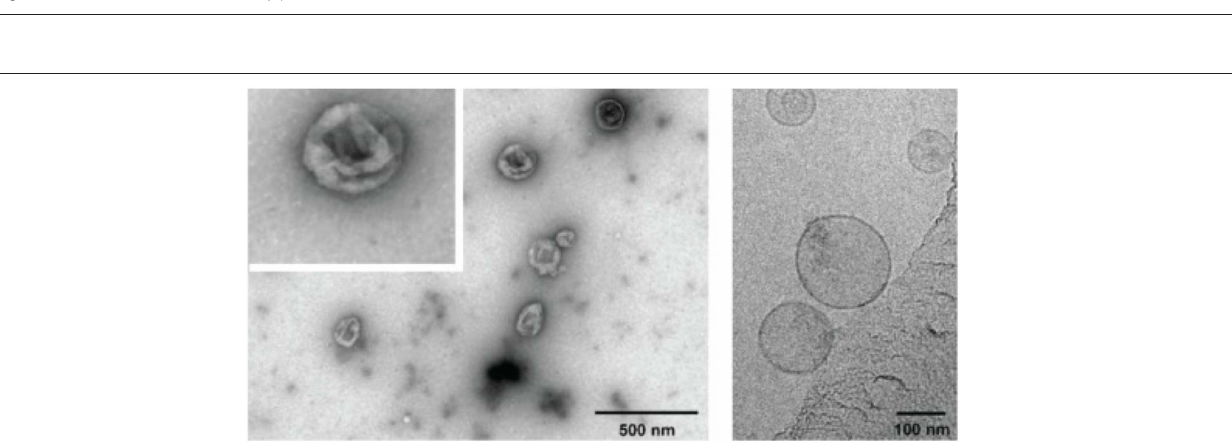
Frontiers in Molecular Neuroscience | www.frontiersin.org